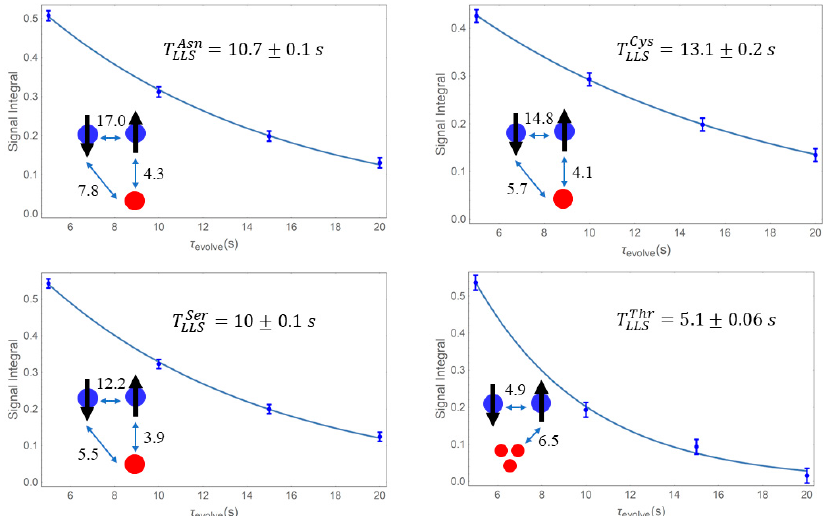
Figure 2. Time evolution of long-lived states excited using the pulse sequence described in the Methods section (Figure 3) and sustained with continuous-wave radiation in asparagine, cysteine, serine, and threonine for periods of τ evolve ∈ { 5 s, 10 s, 15 s, 20 s } . Determined lifetimes, T LLS , were derived from a Monte Carlo fitting of an exponential function, I ( t ) = I ( 0 ) ∗ exp (− (cid:3099) (cid:3280)(cid:3297)(cid:3290)(cid:3287)(cid:3297)(cid:3280) are proportional to the noise of each spectrum; for each molecule, spin systems are shown along with the known values for scalar coupling constants within the system (adjacent to arrows, in Hz).